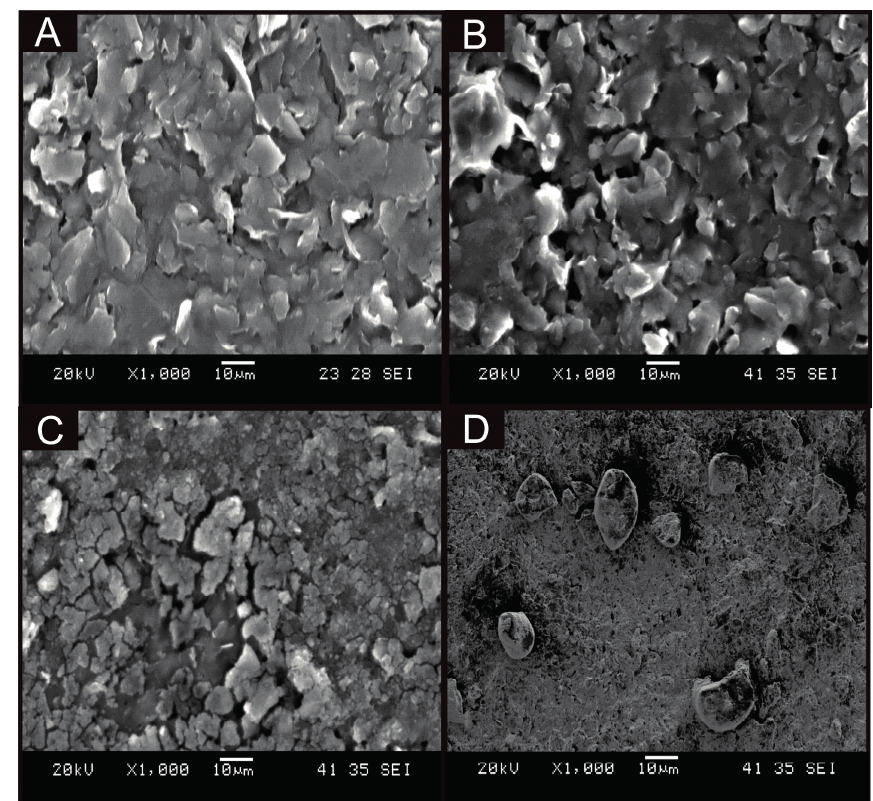
Figure 2. Typical SEM images of a bare standard-SPE ( A ), bulk-CoPC SPE ( B ) and a standard-SPE modified with 20 µg and 70 µg nano-CoTAPC ( C & D